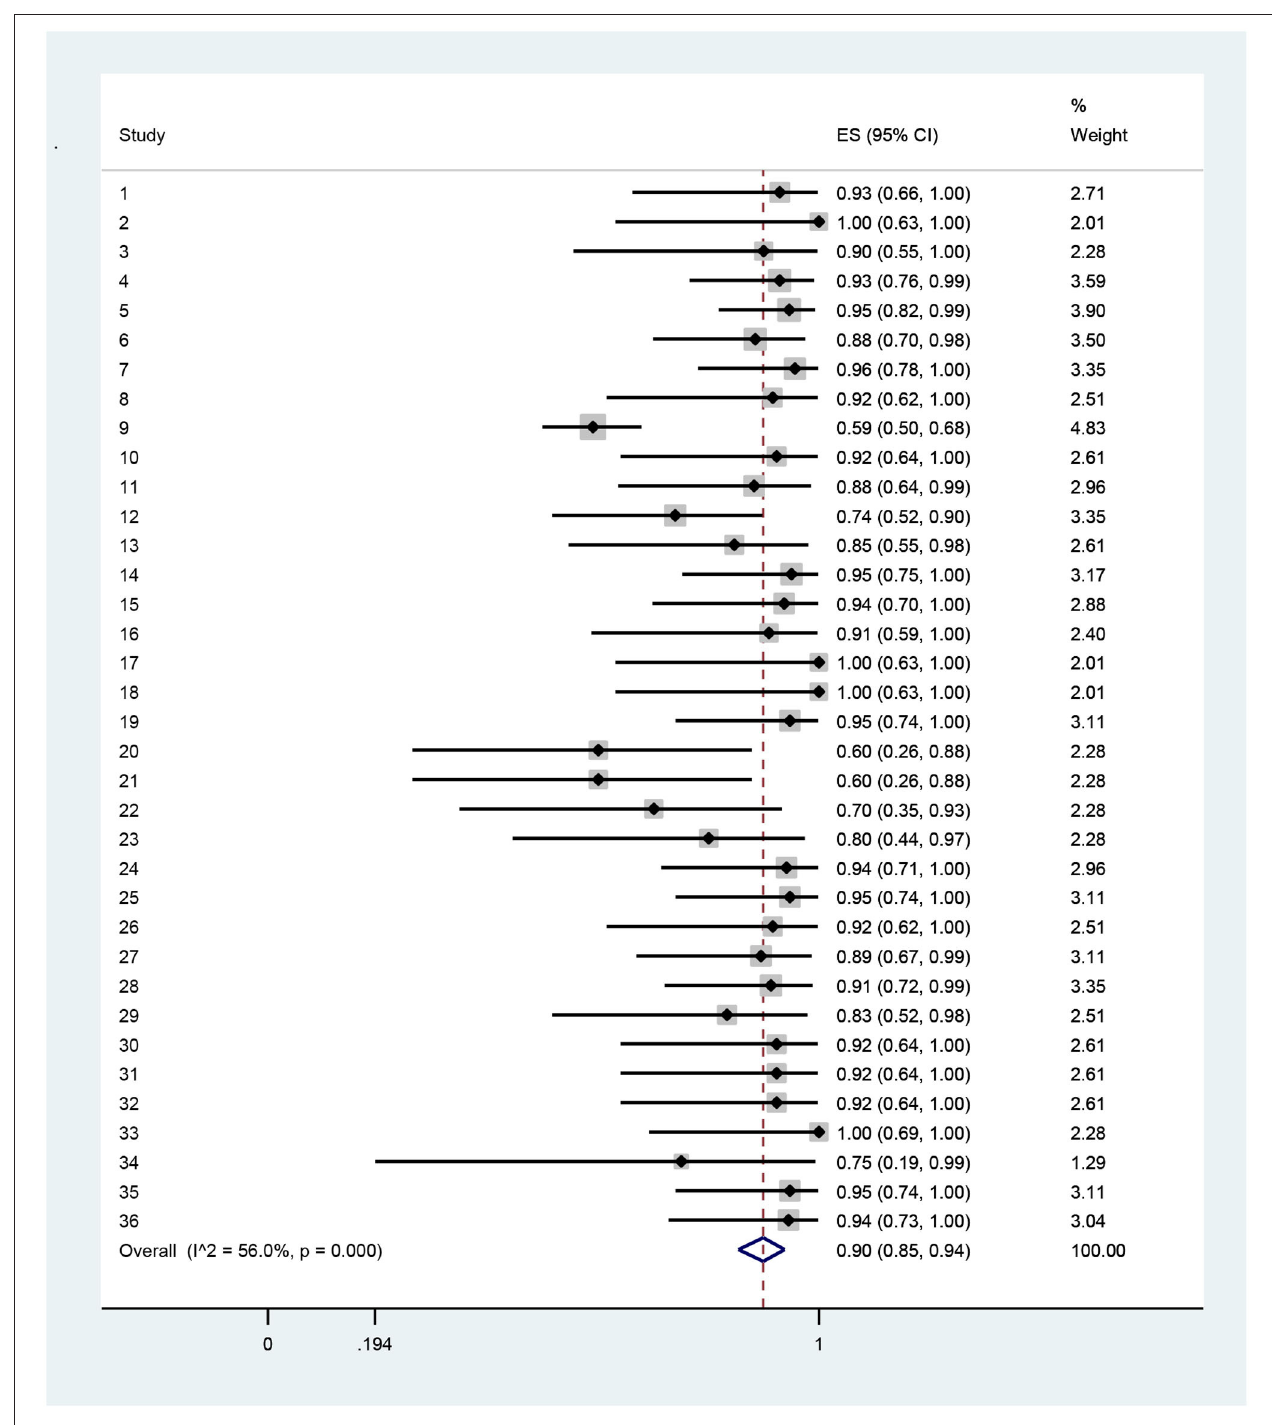
FIGURE 3 | Forest plot of estimates and 95% confidence intervals of the managerial efficiency among Iranian hospitals.